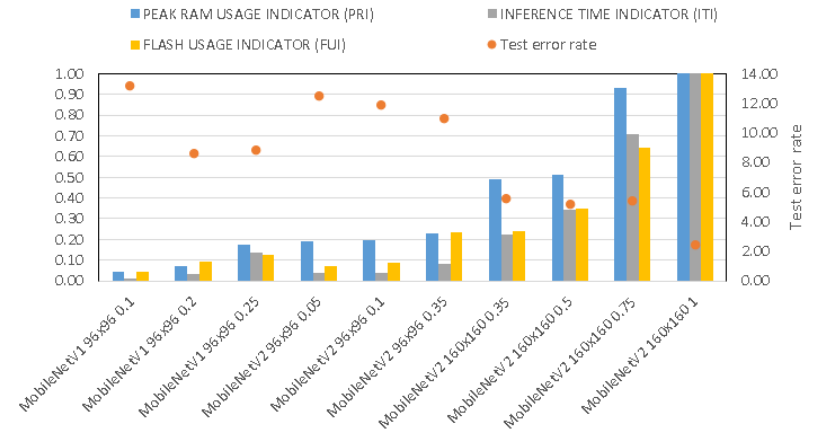
Figure 8. Computational indicators for the tested MobileNet architectures.